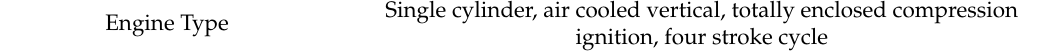
Table 2. The specification of